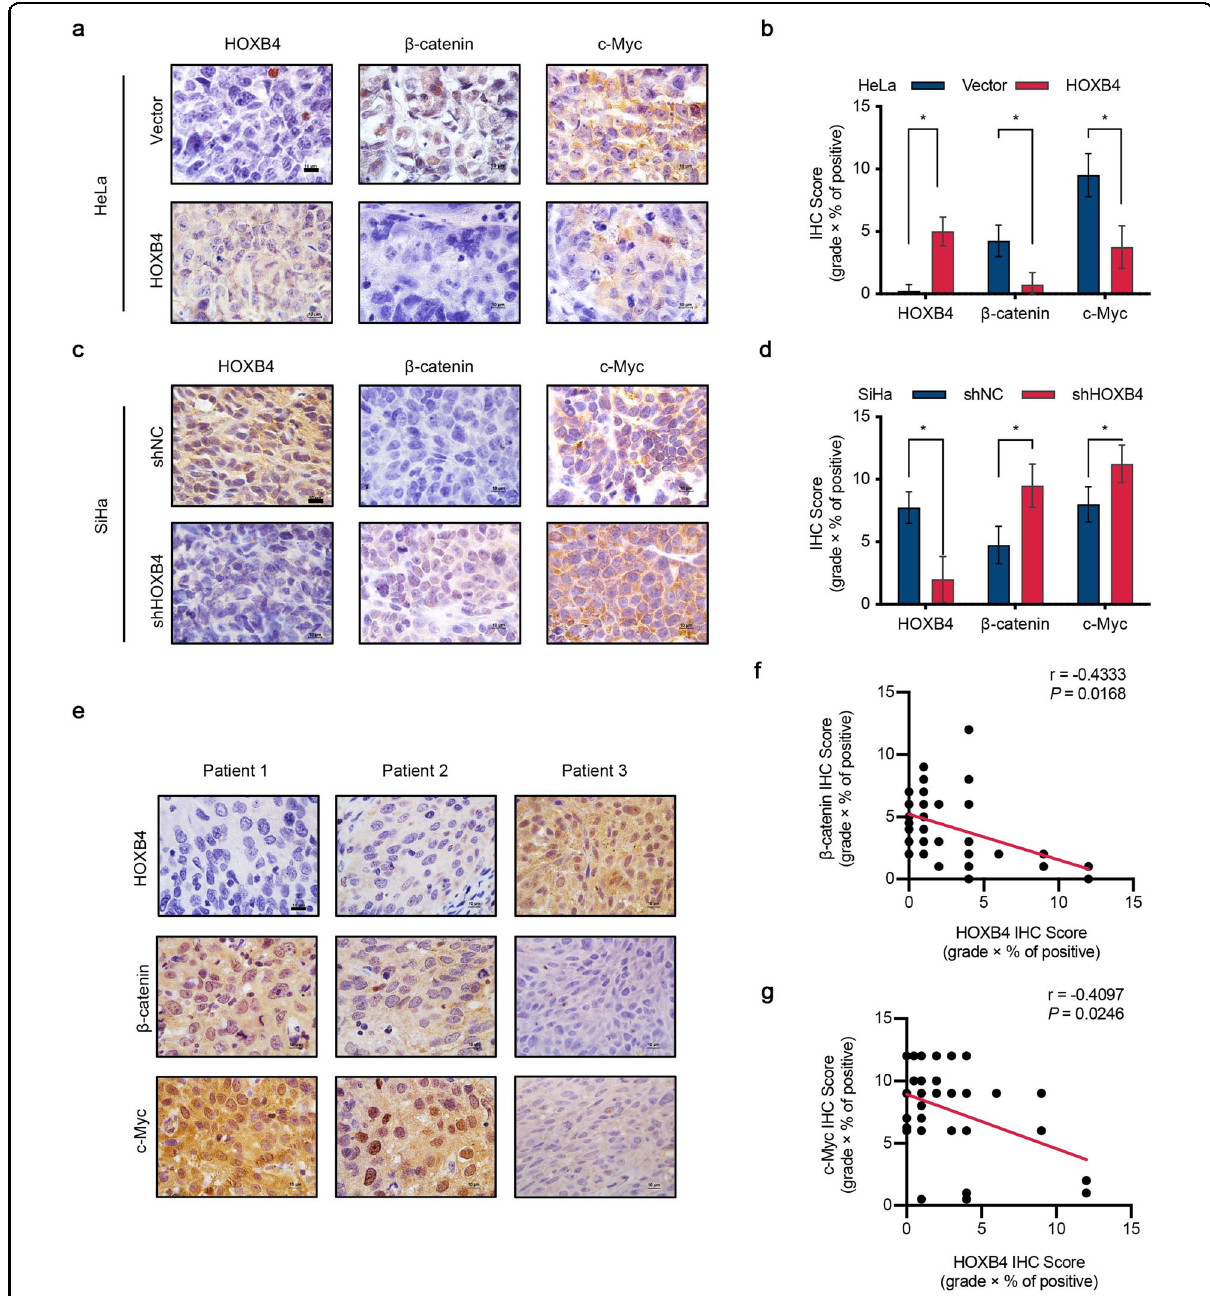
Fig. 6 HOXB4 was negatively correlated with β -catenin. a – d Expression of HOXB4, β -catenin, and c-Myc in vivo. The expression of HOXB4, β -catenin, and c-Myc was measured in the xenograft tumors formed by HOXB4-modi fi ed HeLa ( a , b ) and SiHa ( c , d ) cells using IHC staining. Representative images were shown. Scale bar: 10 μ m. e – g Expression of HOXB4/ β -catenin/c-Myc in human cervical cancer. IHC analysis of HOXB4, β -catenin, and c-Myc ( e ) and quanti fi cation of IHC scores ( f , g ) of human cervical cancer samples. Representative images ( e ) were shown. Scale bar: 10 μ m. Correlation between HOXB4 and β -catenin ( f ) or c-Myc ( g) was calculated. n = 30, Pearson chi-square